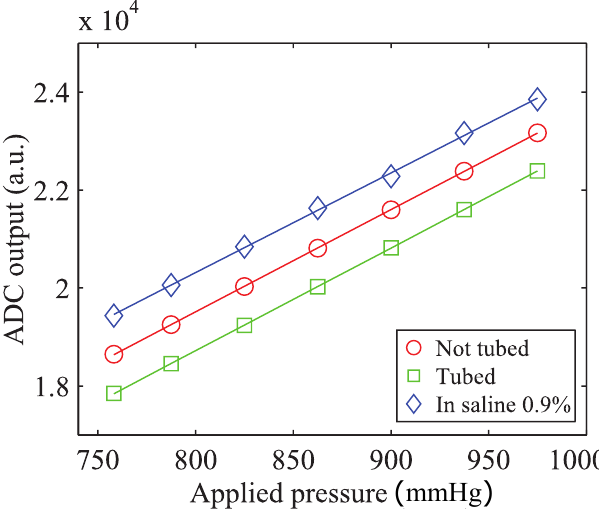
Figure 7. Functional testing of the packaged sensor before (red, circle) and after (green, square) its integration in the connector tube and in saline solution 0.9% (blue,